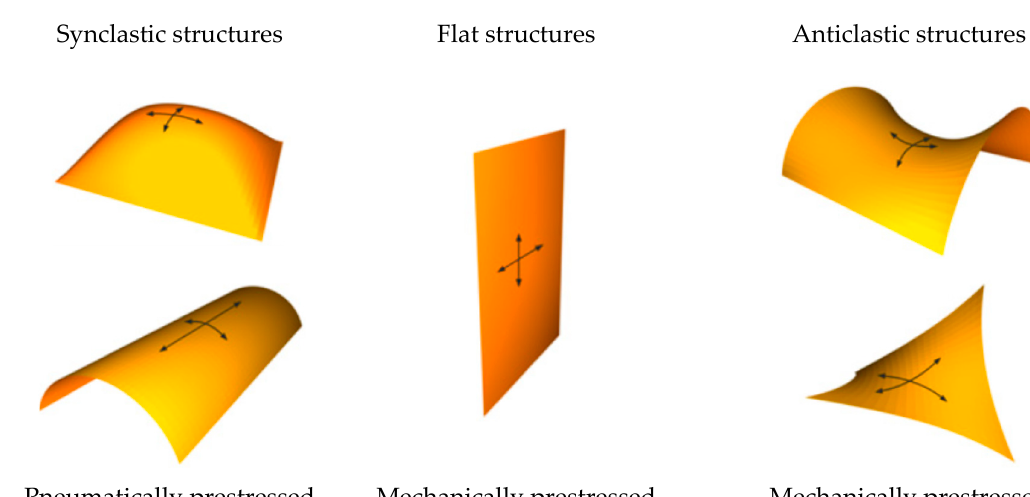
Figure 8. Typical shapes of membrane structures (reproduced from [57]).